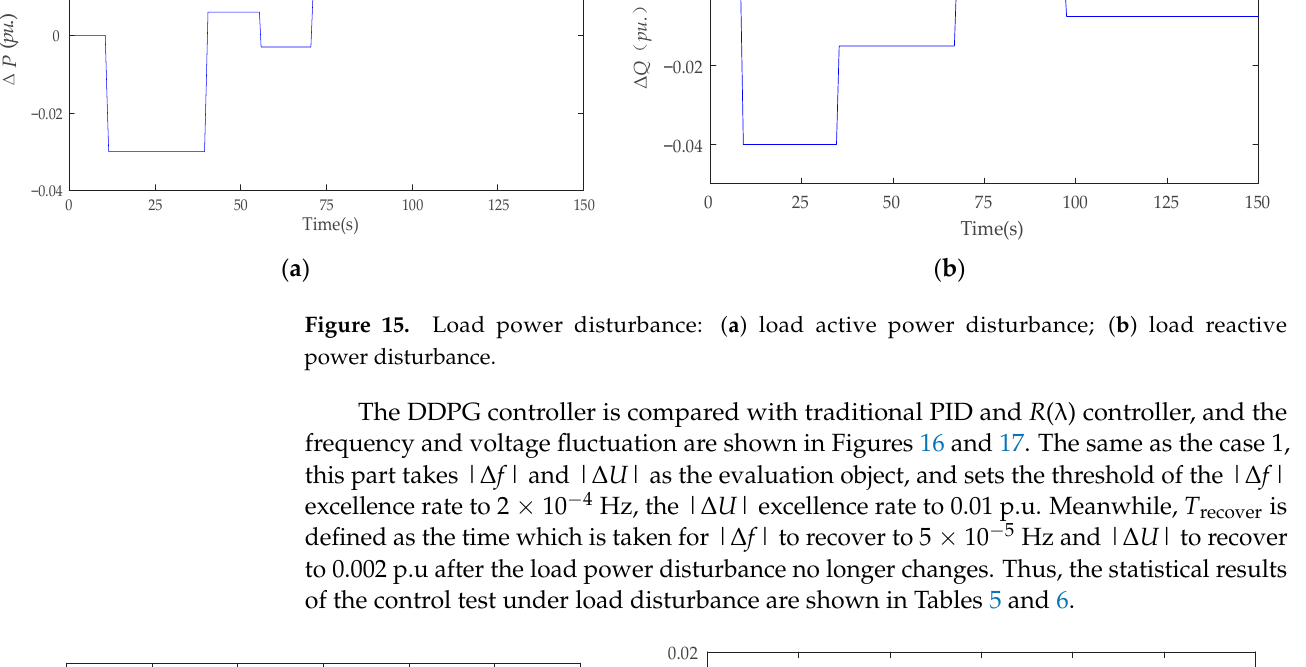
Figure 15. Load power disturbance: ( a ) load active power disturbance; ( b ) load reactive power dis- turbance.